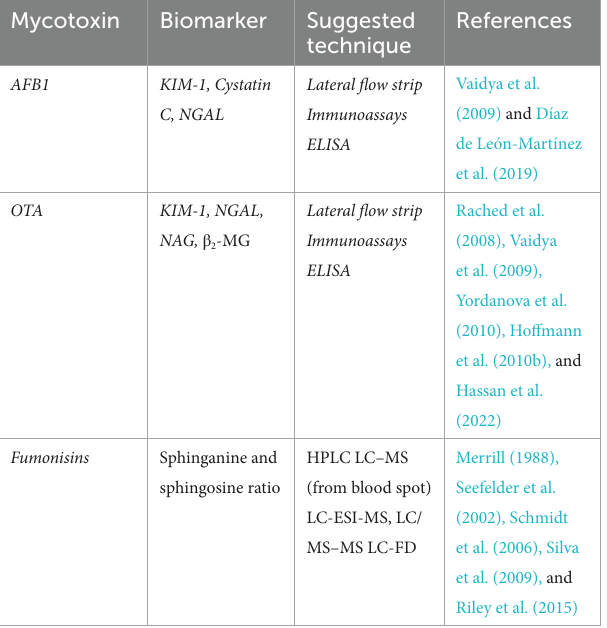
TABLE 2 Kidney biomarkers after mycotoxin exposure: a possible way to detect mycotoxin exposure. Mycotoxin Used Biomarker